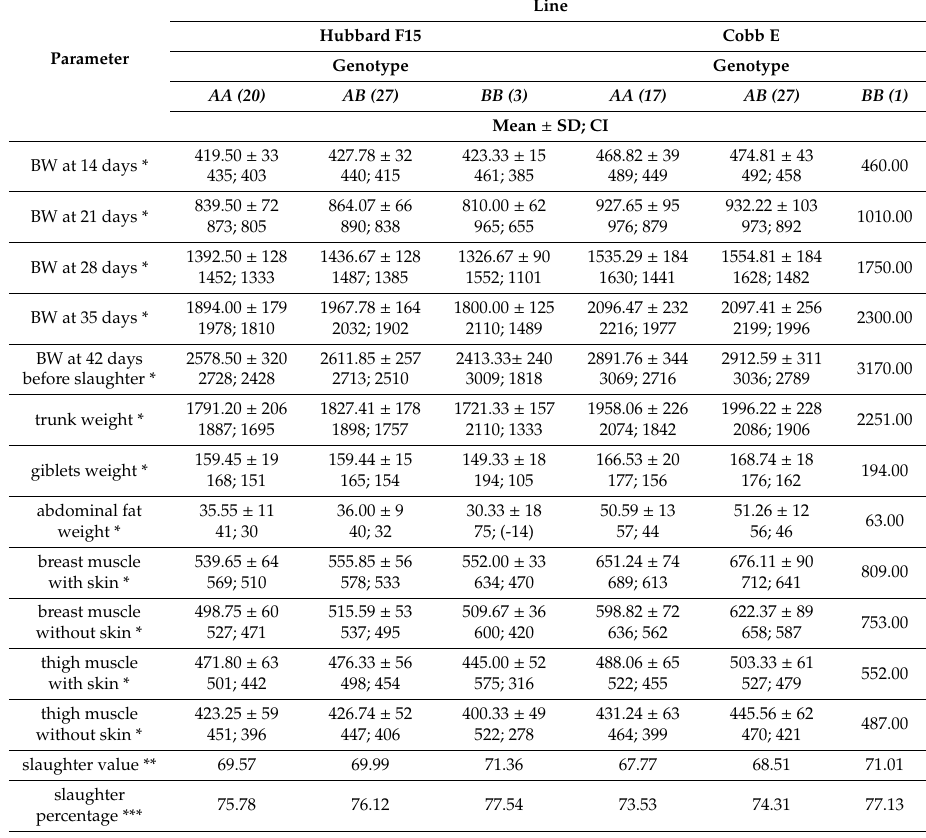
Table 6. The average growth performance and carcass traits in the chicken population (according to IGFBP2